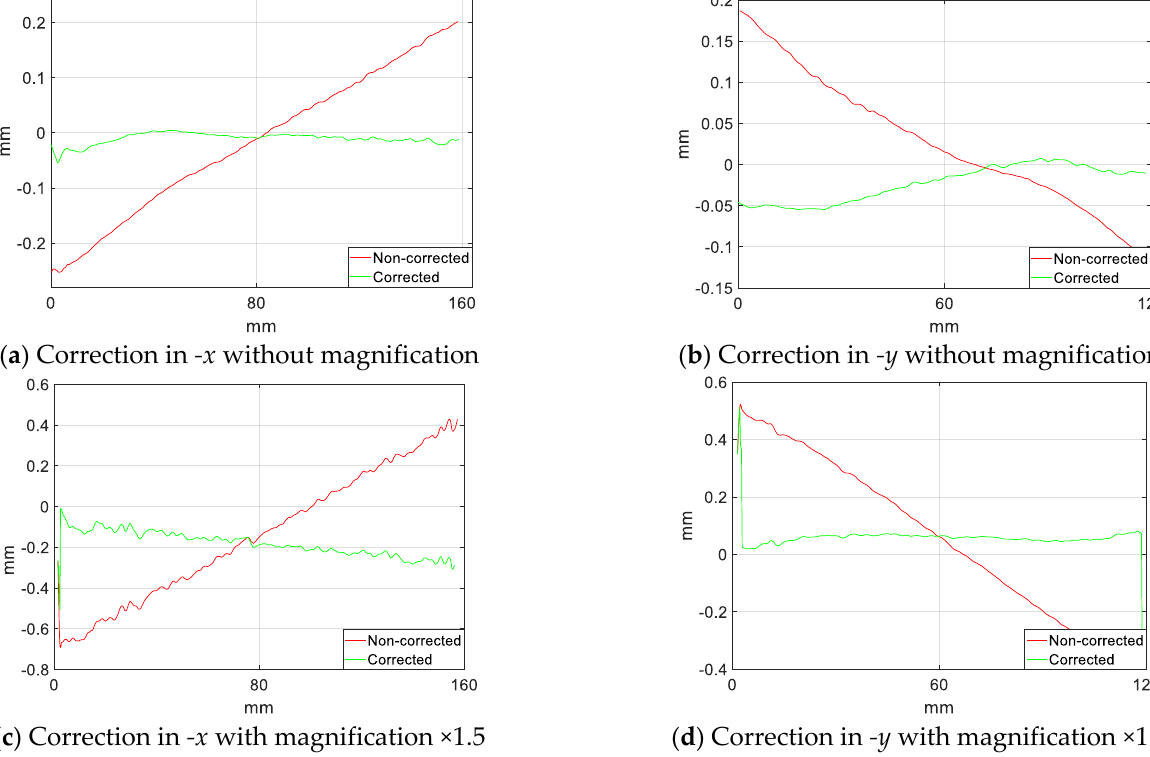
Figure 5. Correction profiles without magnification ( a , b ) and magnified ×1.5 ( c , d ).